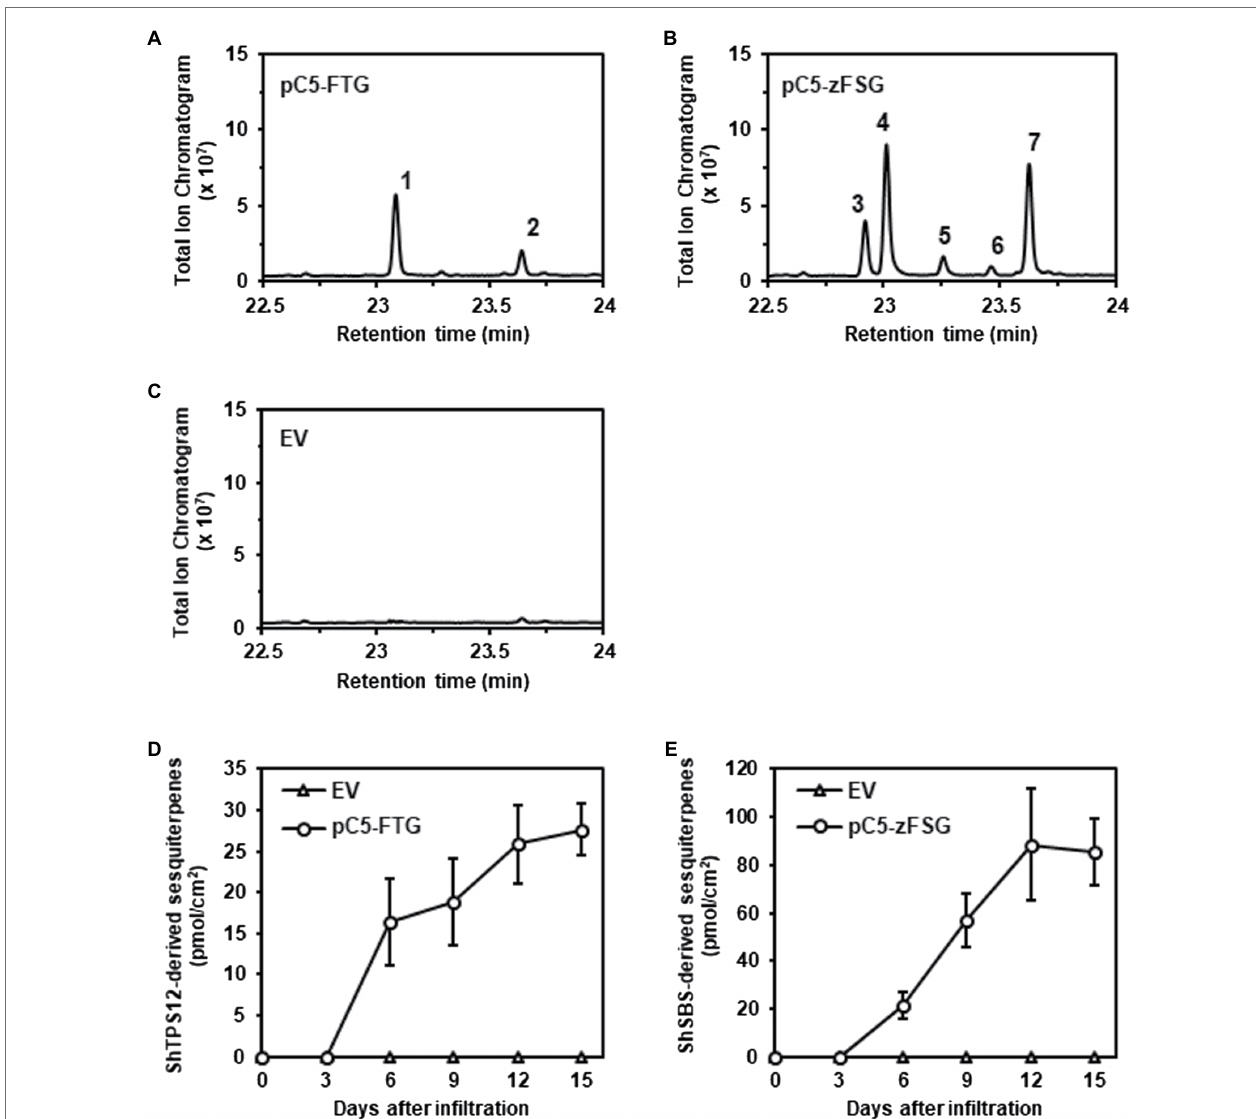
FIGURE 4 | Accumulation of ShTPS12- and ShSBS-derived sesquiterpenes in tomato leaves expressing the multicistronic constructs. Terpenes were extracted from tomato leaves infiltrated with Agrobacterium carrying the pC5-FTG construct (A) , the pC5-zFSG construct (B) , or the empty pMCS vector (EV) (C) and were analyzed by GC–MS (total ion chromatograms are shown). ShTPS12-derived sesquiterpenes: 1, β -caryophyllene; 2, α -humulene. ShSBS-derived sesquiterpenes: 3, ( − )- endo - α -bergamotene; 4, (+)- α -santalene; 5, ( − )- exo - α -bergamotene; 6, ( − )- epi - β -santalene; and 7, (+)- endo - β -bergamotene. The total amounts (pmol/cm 2 leaf area) of ShTPS12-derived (D) and ShSBS-derived (E) sesquiterpenes were determined in tomato leaves at different time points after the Agrobacterium infiltration. Data are means ± SEM ( n =